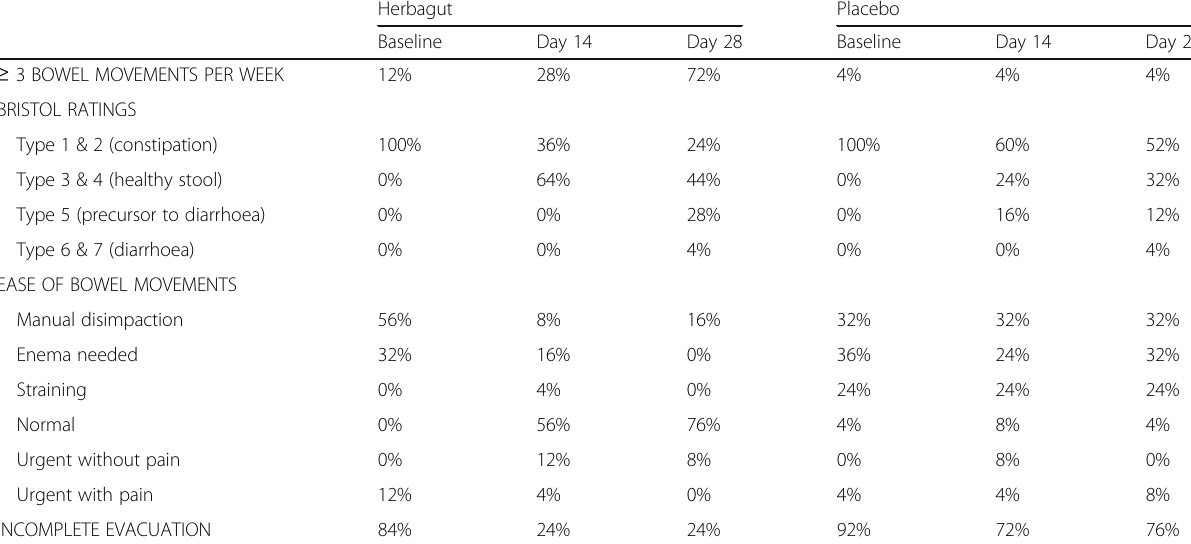
Table 2 Patient Daily Diary changes over 28-day intervention (percentages represent proportion of participants for each measure)